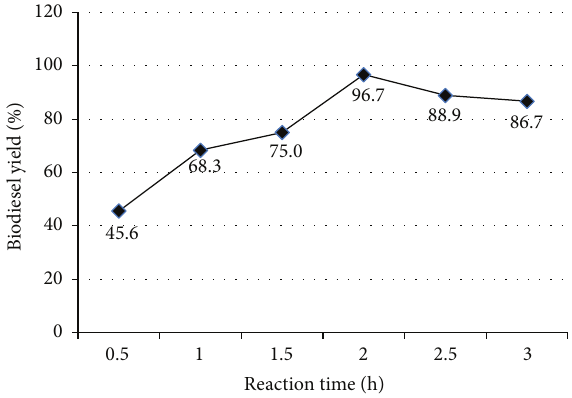
Figure 8: Reaction time (h) versus biodiesel yield (%).